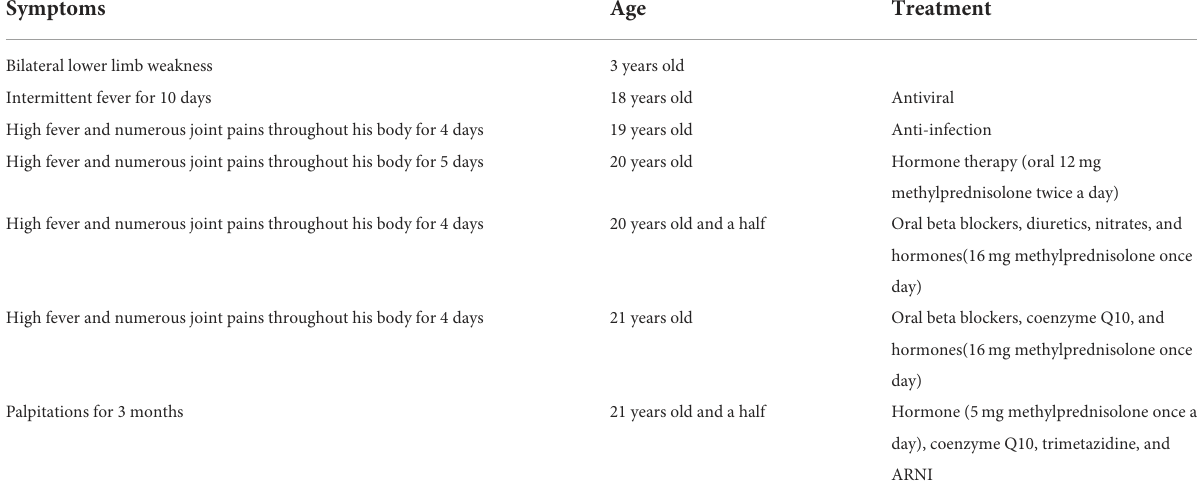
TABLE 1 The patient’s timeline of admission, diagnosis and